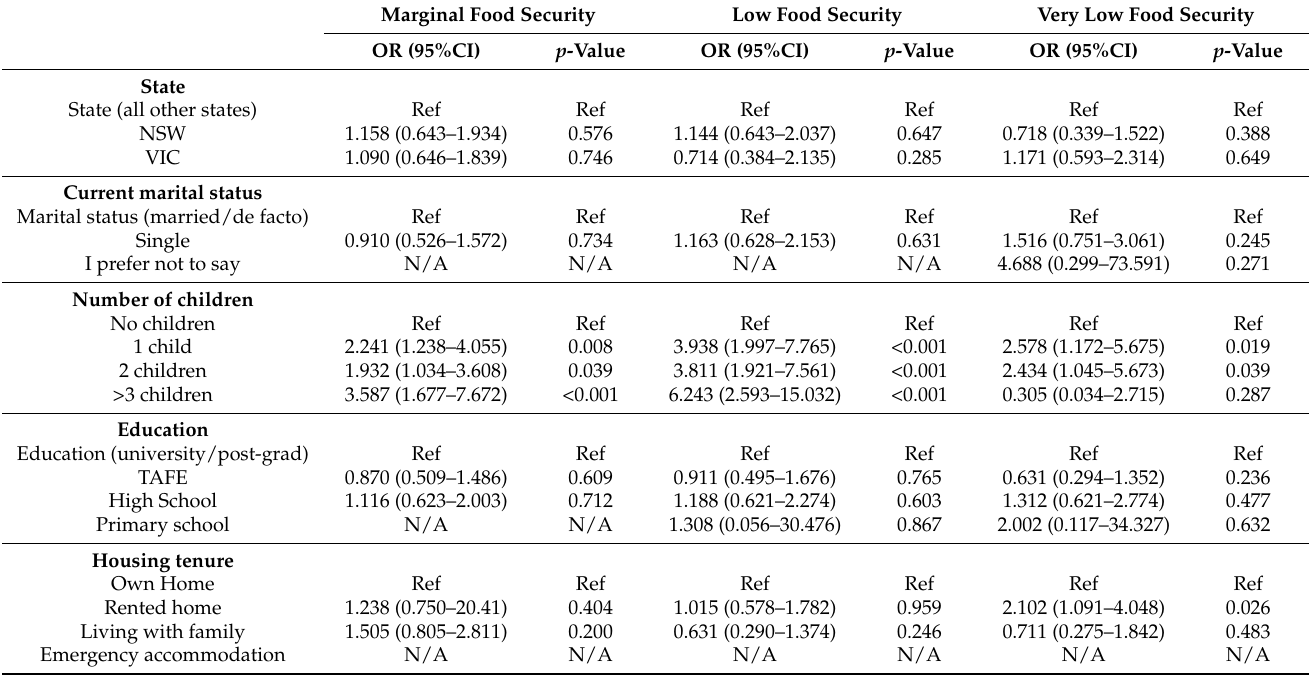
Table 3. Association between risk factors and food insecurity status during COVID-19 in Australia in 2020 multivariable logistic